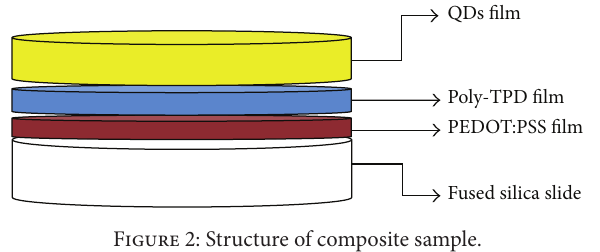
Figure 2: Structure of composite sample.